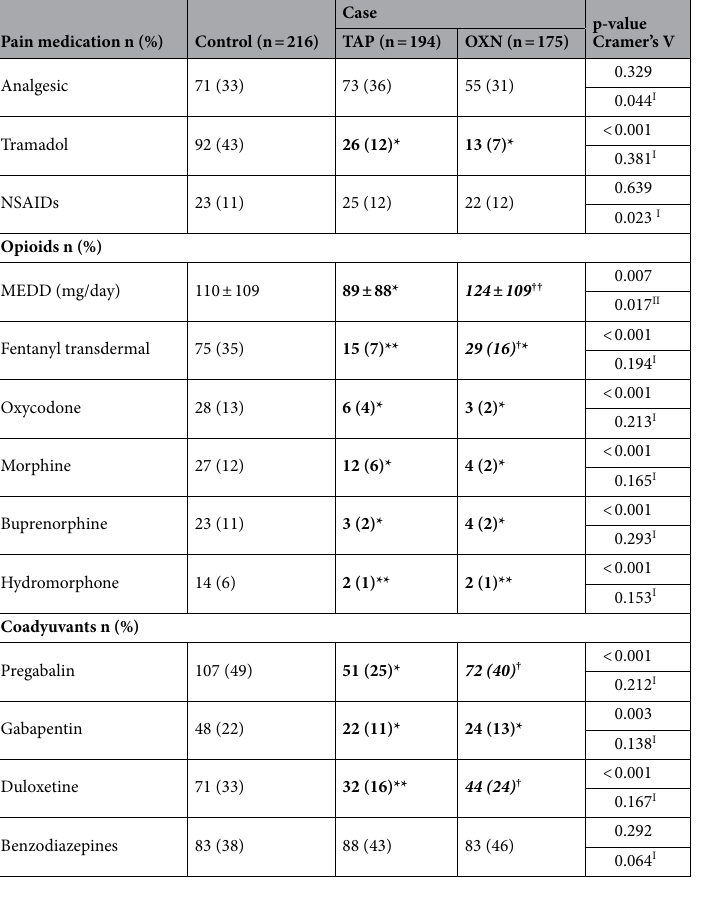
Table 2. Analgesic drug prescription in control, and tapentadol (TAP) and oxycodone/naloxone (OXN) cases groups for chronic non-cancer pain. MEDD morphine equivalent daily dose. Comparison cases vs. control, *p < 0.05, **p < 0.001 and † p < 0.05 tapentadol vs. oxycodone/naloxone, cell in italics denotes also significant differences between tapentadol and oxycodone/naloxone. Effect size was determined as follows: For Chi- square χ 2 test using I Cramer’s V (effect size < 0.2 small, 0.2 < effect size < 0.6 intermediate and effect size > 0.6 large effect). II Eta squared for One-Way ANOVA (effect size of 0.01–0.04 small, 0.06–0.11 intermediate and 0.14–0.2 large effect). Large effect size is written in bold font.